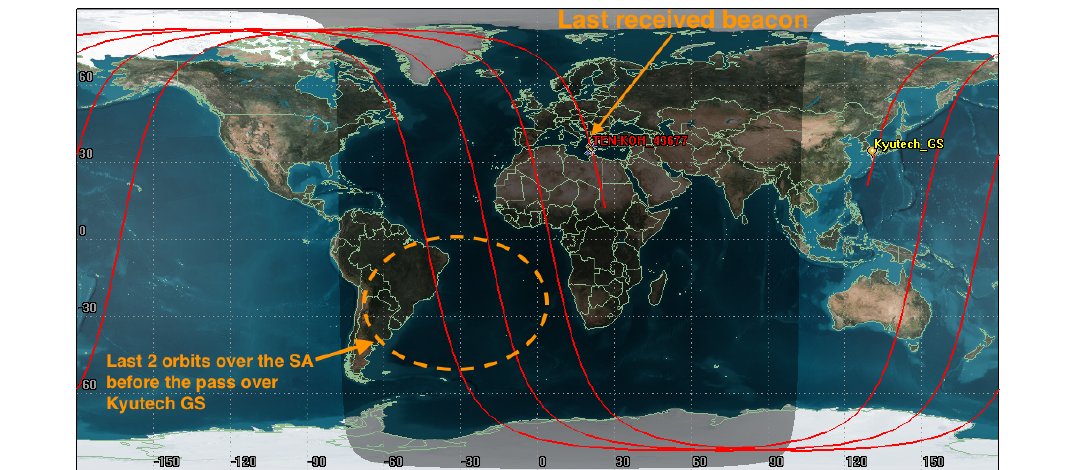
Figure 16. Ten-Koh orbit ground-tracks when the satellite is suspected to have failed. Following a beacon reception in Greece, Ten-Koh flew over the SA region in two consecutive orbits (shown in orange) before passing over the Kyutech ground station (yellow mark) in Japan on 19 March 2018.